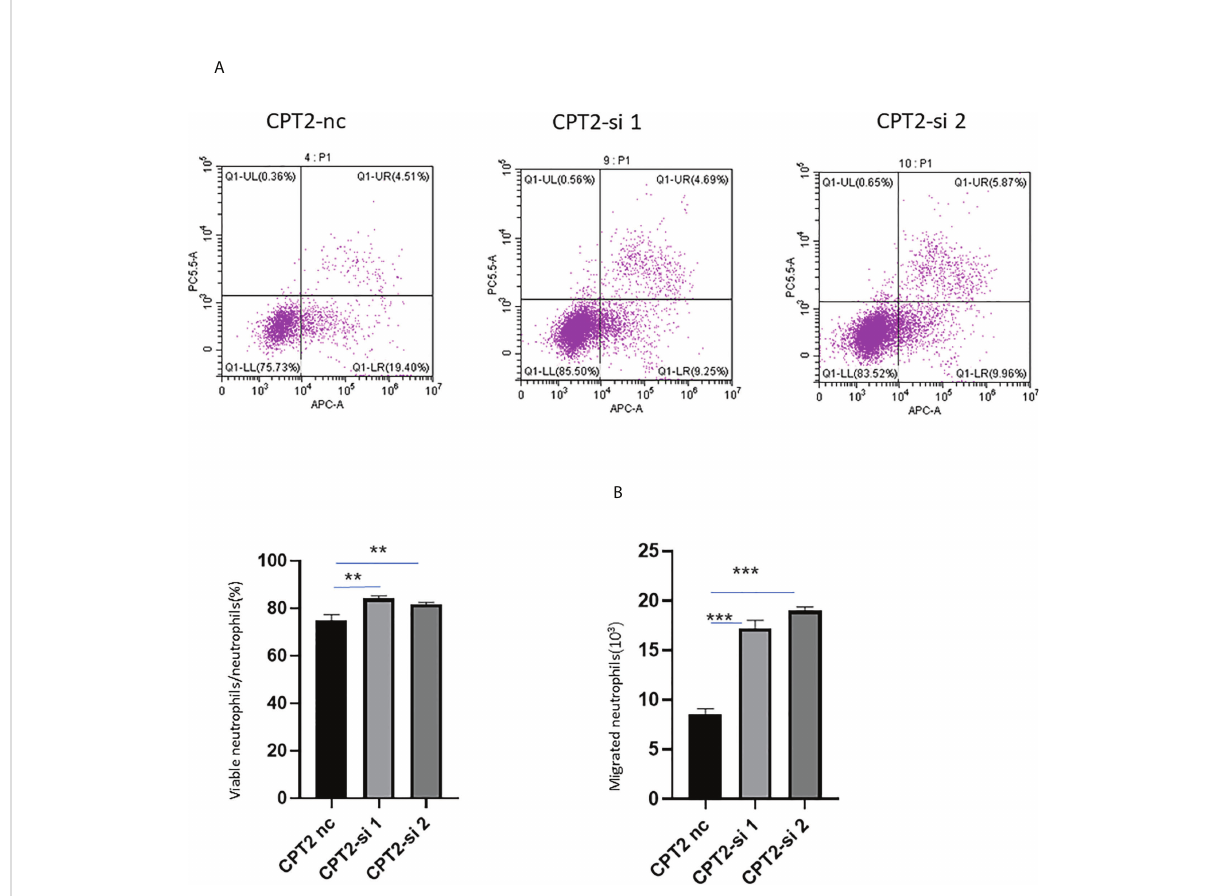
FIGURE 9 CPT2 modulates migration and apoptosis of neutrophils. (A) Migration of neutrophils toward CM from CPT2-si and CPT2-nc RKO cells was evaluated using in vitro Transwell migration assay in triplicate (one-way ANOVA test). (B) Tumor cell-derived conditioned medium from RKO cells with different expressions of CPT2 alter neutrophil survival. Data are presented as means ± SEM. **p < 0.01; ***p <